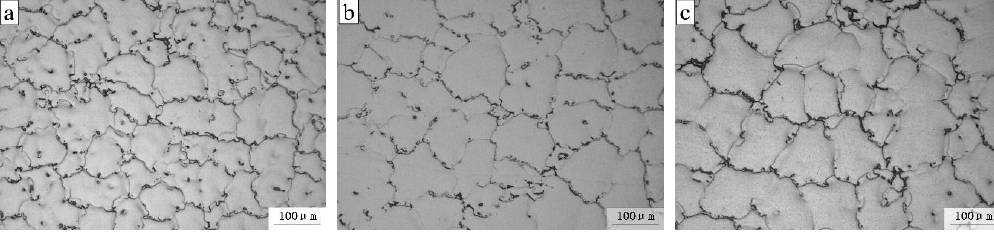
Figure 5. Microstructures of as-cast ZK60 alloy treated by fixed-frequency ultrasonic vibration at ( a ) center; ( b ) 1/2R; ( c ) edge position of billet.